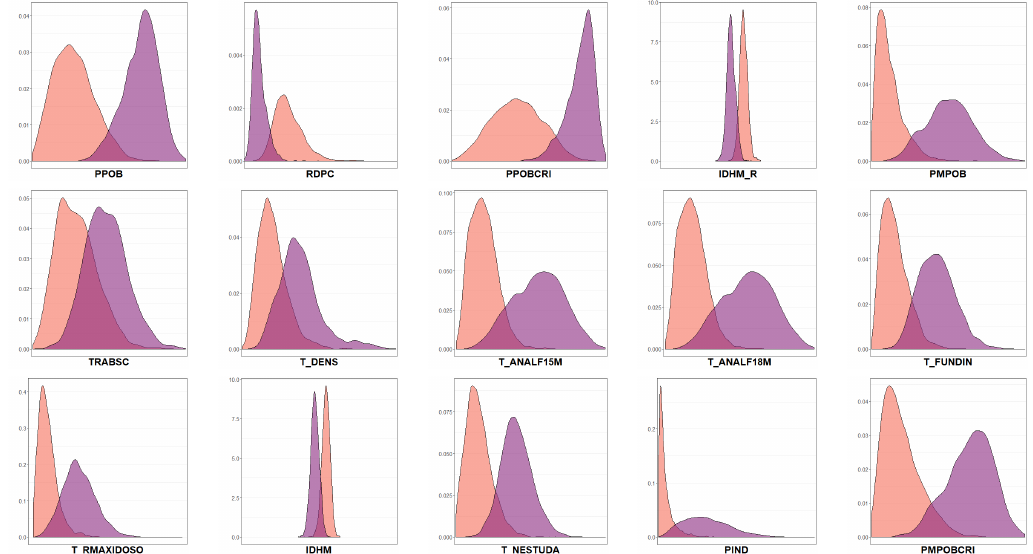
Figure 8. The distribution behavior of some variables over the binary utilization rate in